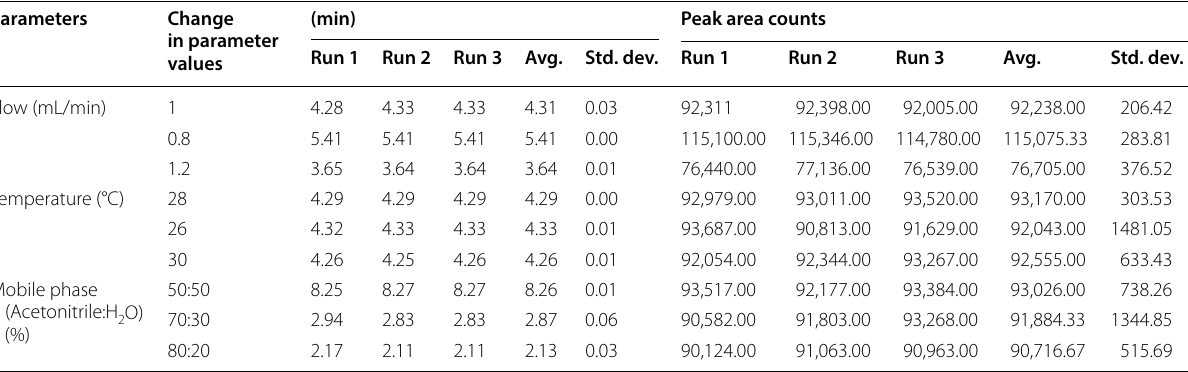
Table 3 Sensitivity and robustness of fluridone detection method